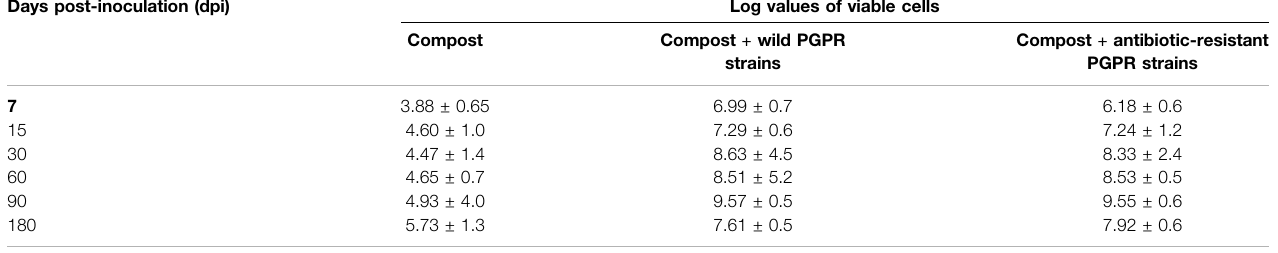
TABLE 2 | Total bacterial population analysis on compost and bioactive compost. Days post-inoculation (dpi)